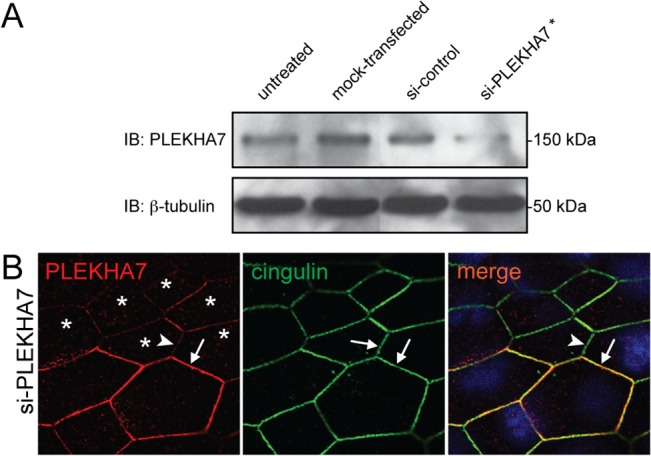
Specificity of anti-PLEKHA7 monoclonal antibody for human PLEKHA7.(A) Immunoblot analysis of lysates from cultured human epithelial cells (SKCO), following treatment with siRNA for PLEKHA7 (siRNA3), control siRNA (untreated and mock-transfected cells for control) using monoclonal antibody 37-8F1. (B) Immunofluorescence analysis of si-PLEKHA7 treated cultures, showing decreased PLEKHA7 junctional (red, Cy3) labeling in PLEKHA7-depleted cells (asterisks, siRNA2) with respect to normal cells. Anti-cingulin antibody (green, Alexa488) was used as control to normalize junctional labeling. The same results were used with cells depleted of PLEKHA7 by three different siRNAs (see Materials and Methods).